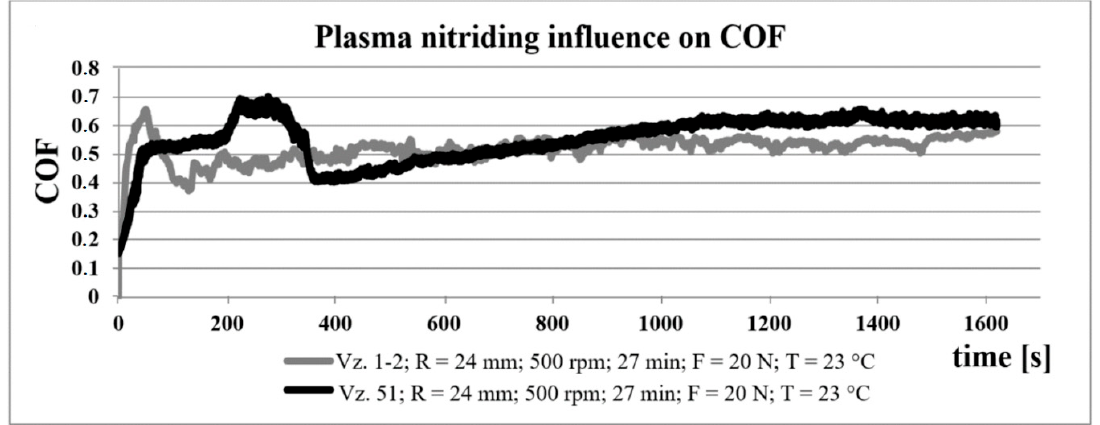
Figure 5. Comparison of coefficient of friction (COF) of nitrided (vz. 1-2) and non-nitrided (vz. 51) specimens; steel equivalent 42CrMo4 (i.e., CSN 41 5142).